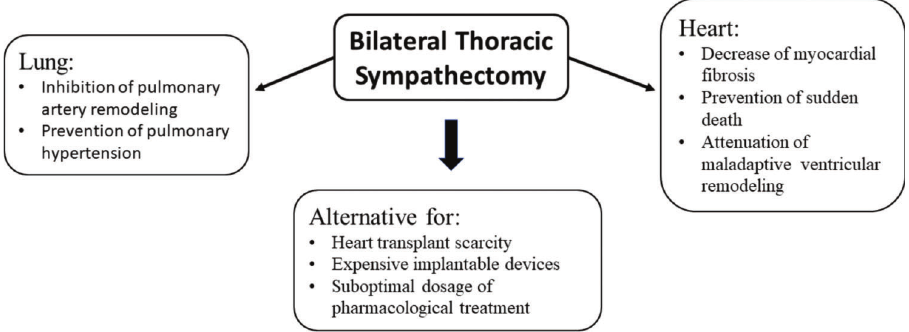
Figure 1 - Bilateral sympathectomy potential benefits for patients with heart